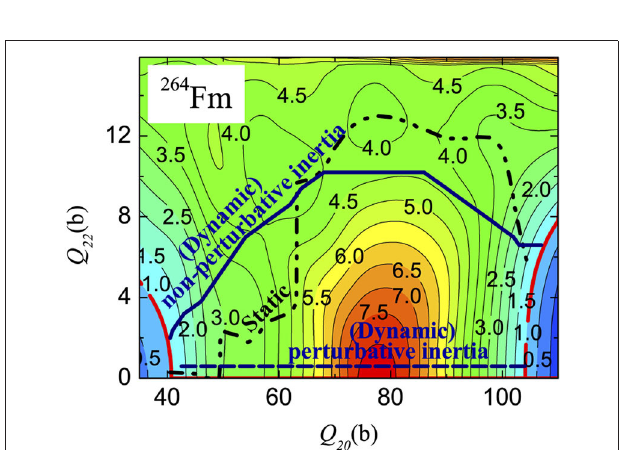
FIGURE 4 | Variation in single-particle energies of neutron (top) and proton (bottom) calculated for 264 Fm along Q 20 (left, at Q 22 Q 20 61b). The Fermi energies are marked with thick dash-dotted lines. The = arrows indicate regions of level-crossings near Fermi energy. The figure is adapted from Sadhukhan et al. [56].